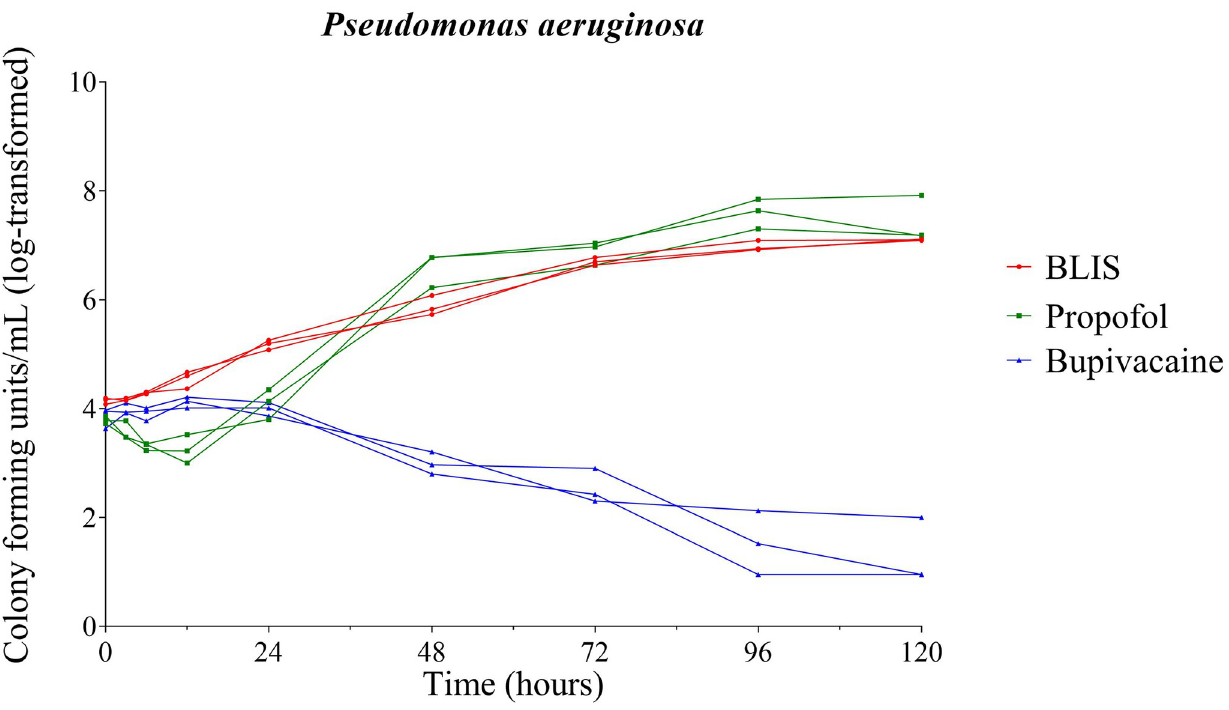
Fig 2. Growth dynamics of Pseudomonas aeruginosa . Growth of inoculated Pseudomonas aeruginosa over time in bupivacaine liposomal injectable suspension (BLIS), propofol, and bupivacaine 0.5%. Each line represents an individual vial; red lines represent BLIS, green lines represent propofol, and blue lines represent 0.5%